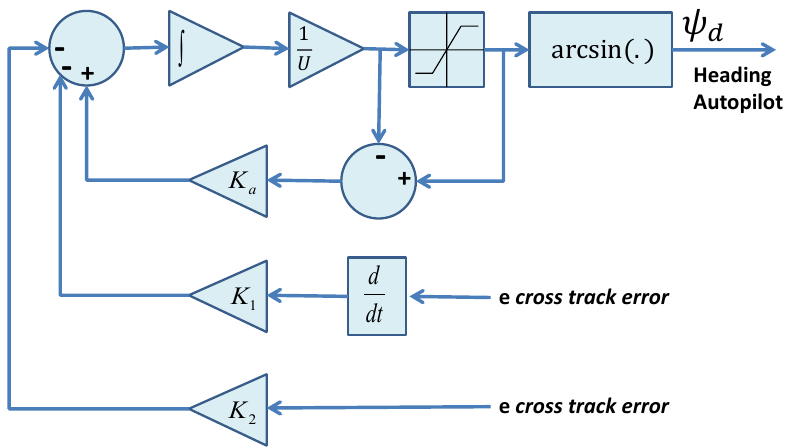
Figure 13. Implementation of the path-following algorithm using an anti-windup technique scheme that includes the so-called D-methodology in